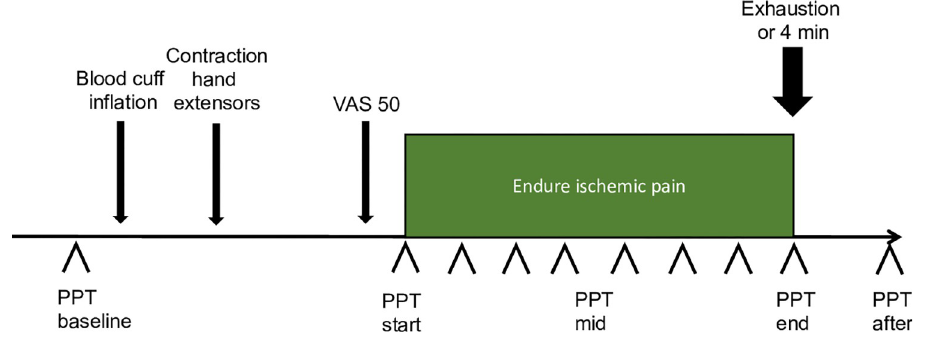
Fig 1. Schematic view of the assessment for conditioned pain